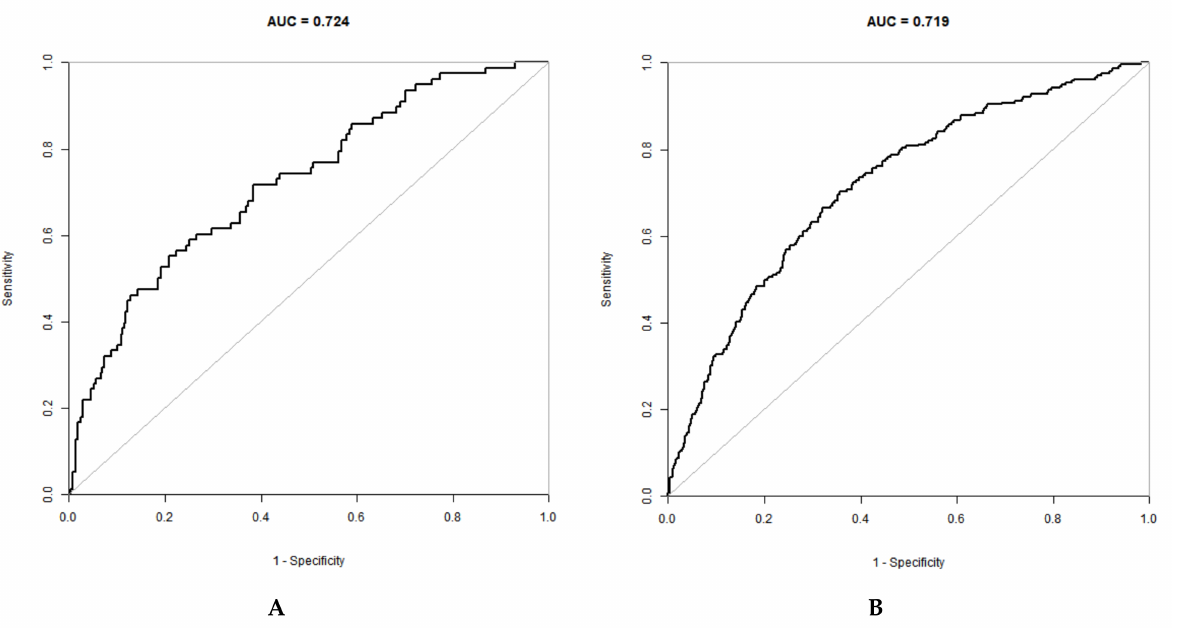
Figure 2. Receiver operating characteristics curve in the training cohort ( A ) and the testing cohort ( B ) for the machine learning